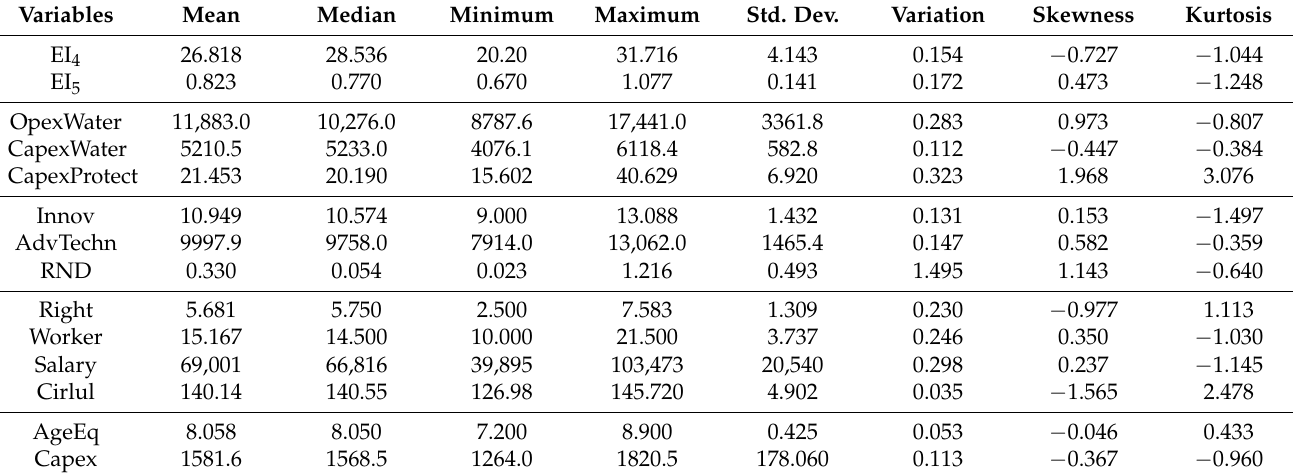
Table 8. Summary of Descriptive